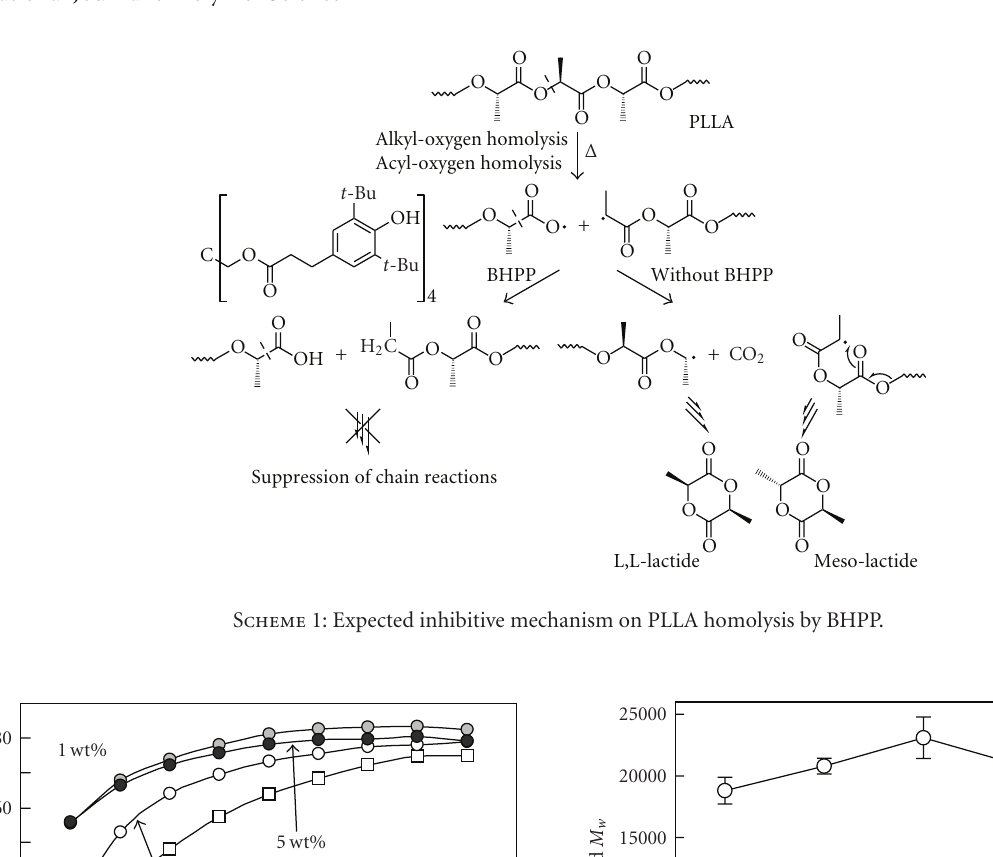
the selective depolymerization of PLLA by MgO catalyst.